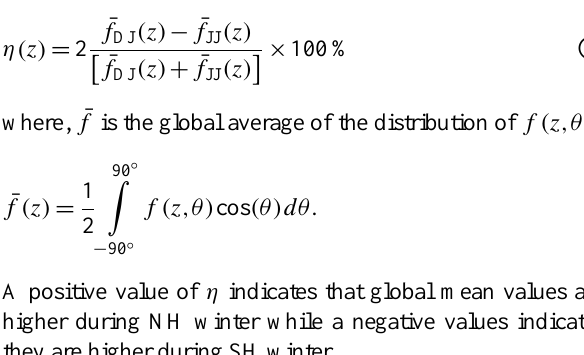
Figure 4 The same as Figure 3 but for the altitude of 25 km.